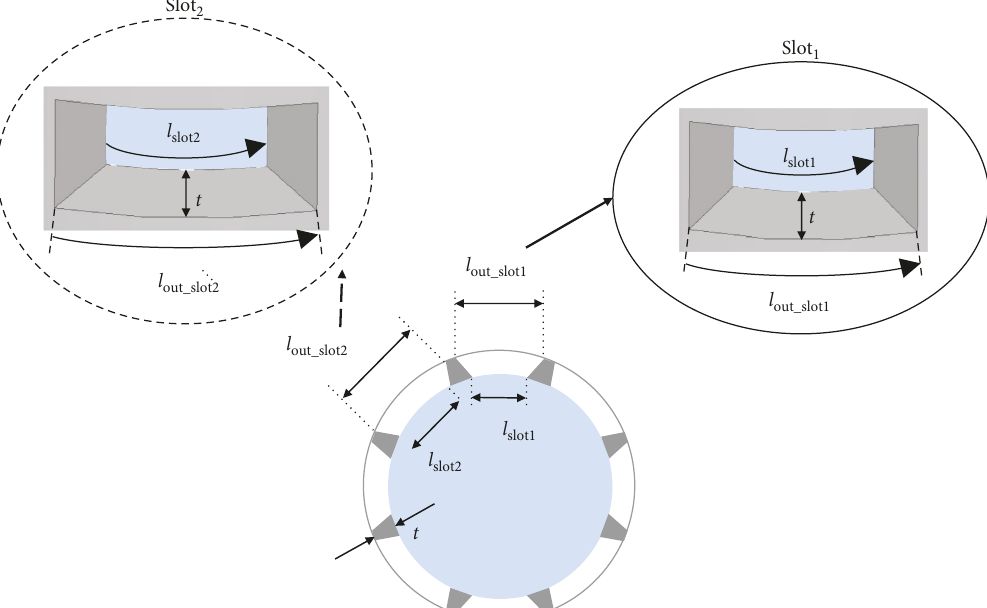
Figure 1: Trapezoidal-shaped slots details.